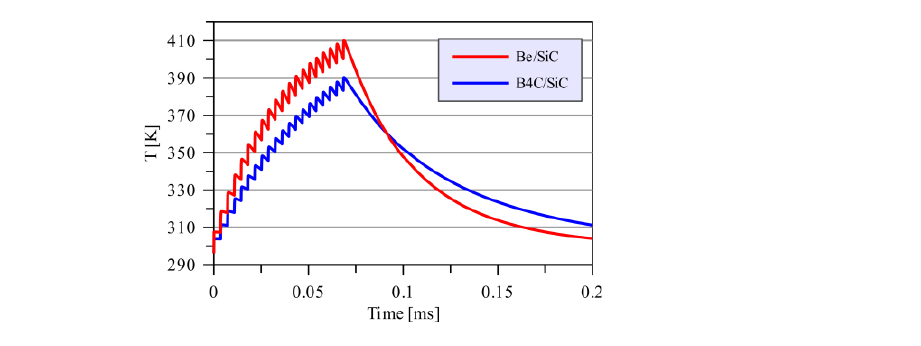
Figure 14. Temperature field in the z-x cross-section plane of MLLs consisting of ( a ) B 4 C/SiC, ( b ) Be/SiC, ( c ) TiC/SiC, and ( d ) WC/SiC multilayers with optimal thicknesses for diffraction, after 20 pulses of 1 mJ energy (10 J/cm 2 incident fluence). The simulation assumed that the incident X-ray beam illuminated only the area within the black dashed line box. Table 7. The highest average